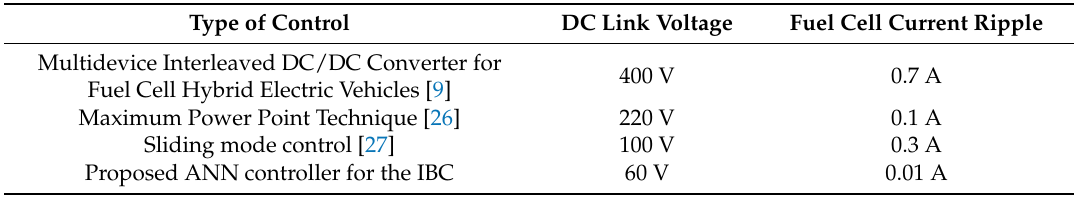
Table 3. Fuel cell current ripple of the of the proposed converter and techniques presented in [9,26] and [27].